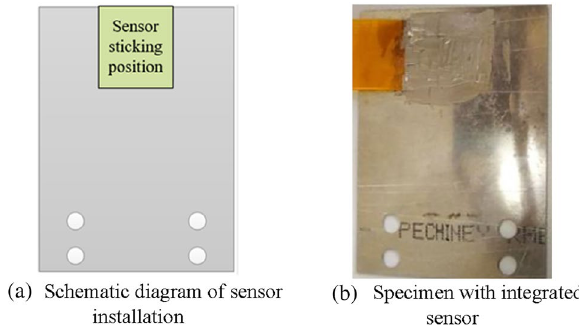
Figure 8. Sensor installation.